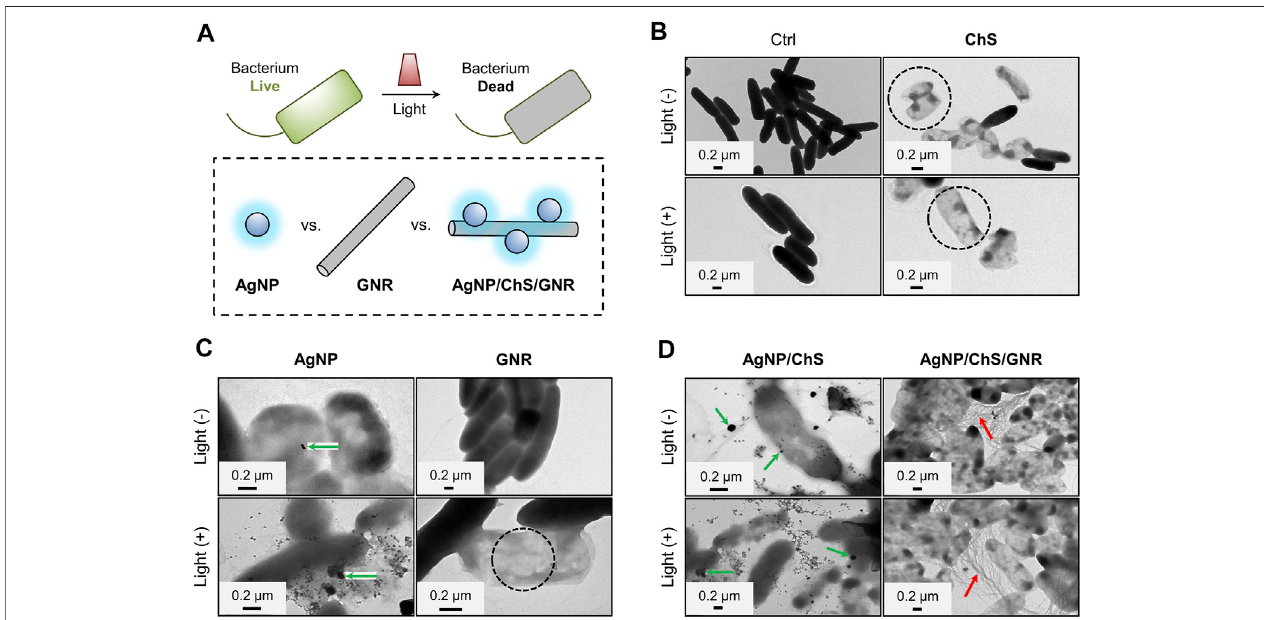
FIGURE 2 | (A) Schematic illustration of the light-triggered bacterial eradication using different materials. TEM images of Pseudomonas aeruginosa (ATCC 27853, 10 6 CFU ml − 1 ) before and after treatment with (B) ChS (2 mg ml − 1 ), (C) AgNP (10 μ g ml − 1 ) and GNR (20 μ g ml − 1 ) (D) ChS/AgNP (2 mg ml − 1 /10 μ g ml − 1 ) and